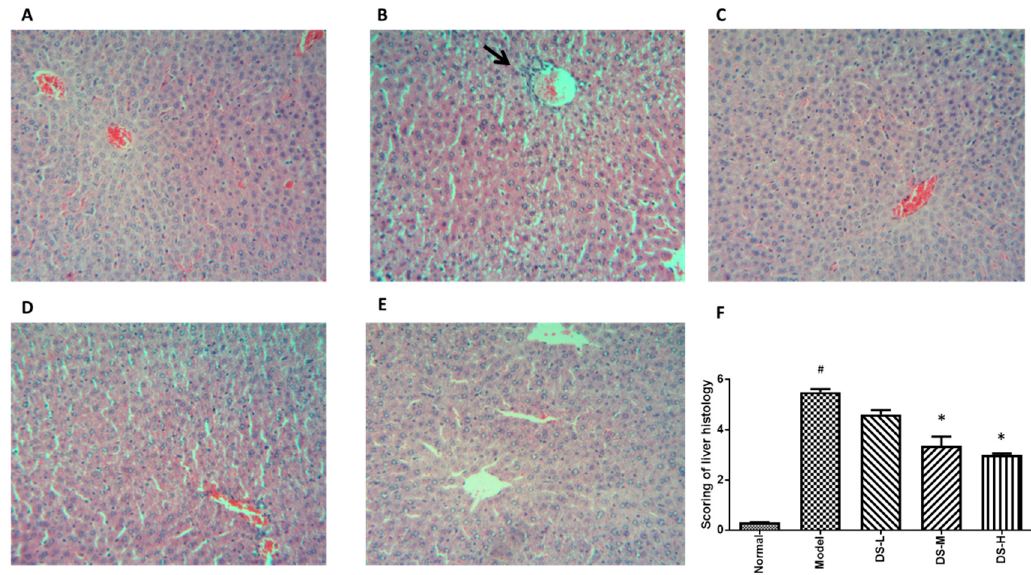
Figure 2. H&E staining results after Danshen treatment in acute ALD (original magnification 100×). ( A ) The normal group had a clear structure of the hepatic lobule, and there were no visible lesions; ( B ) In the model group, typical pathological characteristics such as inflammatory infiltration (arrows) can be detected; ( C – E ) Treatment with Danshen (0.093, 0.28, 0.84 g/kg) at 0.2 mL for nine days attenuated the inflammation in the liver; ( F ) Scoring of liver histology of acute ALD mice with Danshen treatment (Mean ± SD). DS-L for low dose of Danshen treatment group (0.093 g/kg); DS-M for middle dose of Danshen treatment group (0.28 g/kg); DS-H for high dose of Danshen treatment group (0.84 g/kg). # p < 0.05, compared with normal group * p < 0.05 when compared with model group.